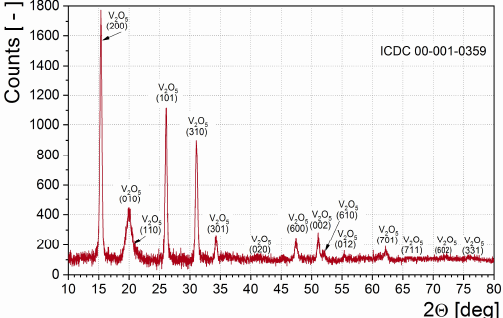
Figure 2. X-ray diffraction patterns for as-sputtered V 2 O 5 thin film.